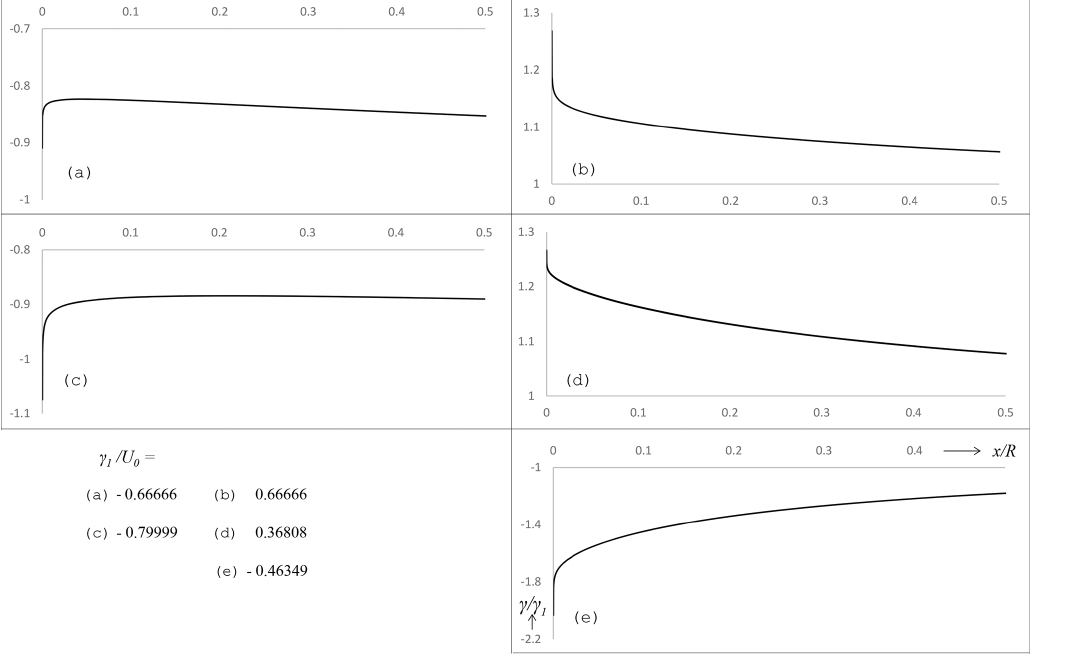
Figure 7. The distribution of the vortex sheet strength γ ϕ ( x ) /γ ϕ, 1 , for flow cases (a) to (e) , defined in Fig. 4. The vertical axes have the same scale, except the axis of (e) , which covers a range of γ 4 times larger.